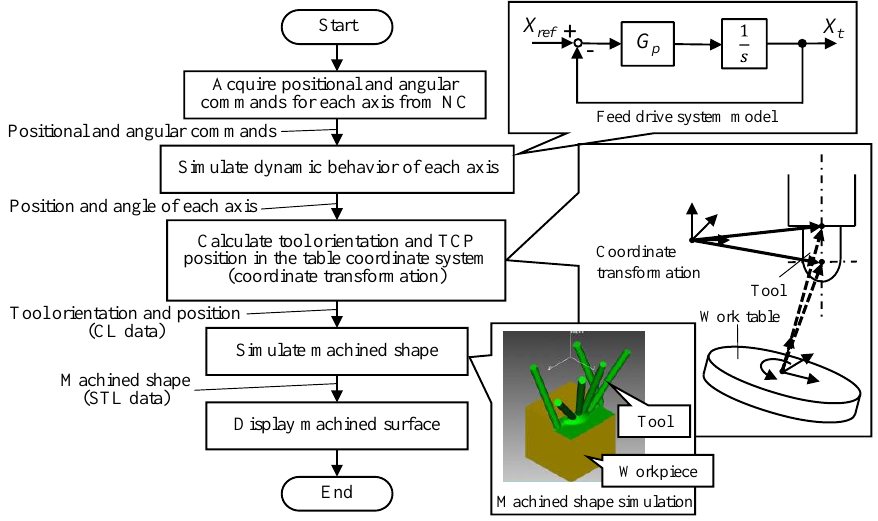
Figure 4. Simulation method for machined workpiece with motion error sources in the five-axis machining center.